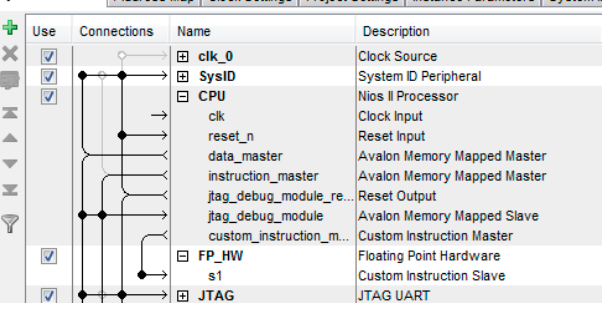
Figure 11. Connecting floating point hardware with the Nios II CPU.